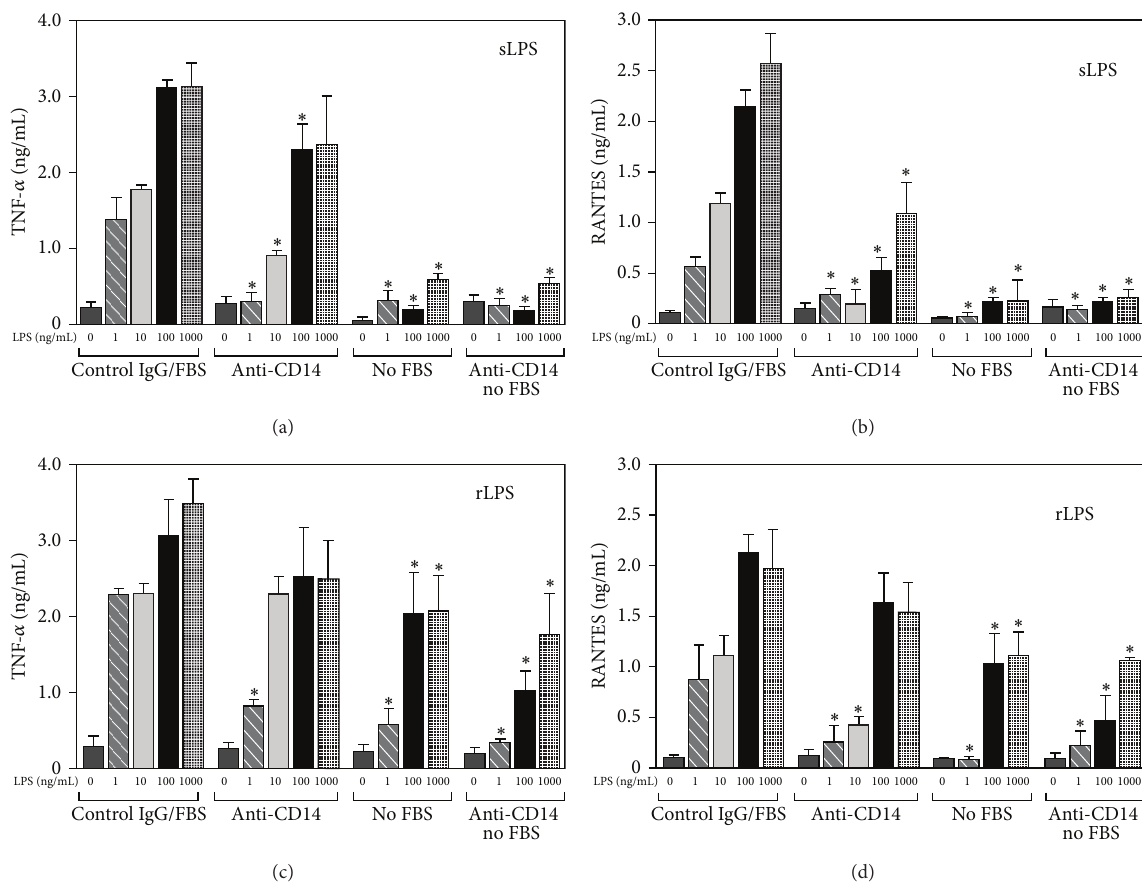
Figure 1: Interference with LPS/CD14 interaction moderately affects TNF- 𝛼 production induced by high concentrations of sLPS or rLPS. RAW264 cells were pretreated with 10 𝜇 g/mL of the anti-CD14 antibody, clone 4C1, or isotype-matched control rat IgG2b (30min, 37 ∘ C) and subsequently stimulated with 1–1000 ng/mL sLPS (a, b) or 1–1000 ng/mL rLPS (c, d) in the presence or absence of 10% FBS, as indicated. Concentrations of TNF- 𝛼 (a, c) and RANTES (b, d) were measured by ELISA tests in supernatants of the cells. Data shown are mean ± SEM form three or four experiments each run in triplicate. ∗ Significantly different from cells stimulated with a corresponding LPS concentration in the presence of control IgG and